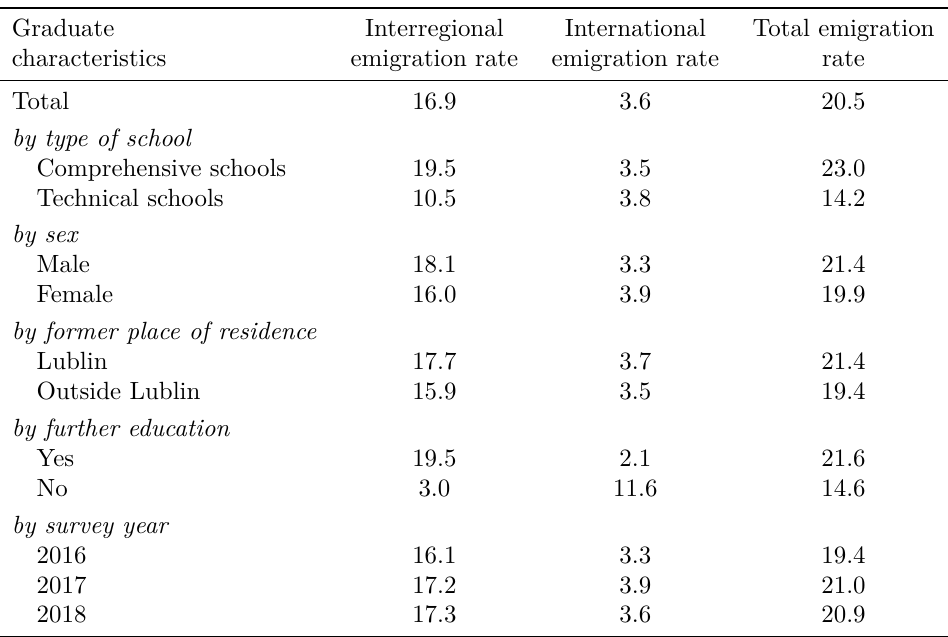
Table 2: Migration rates by selected respondent characteristics